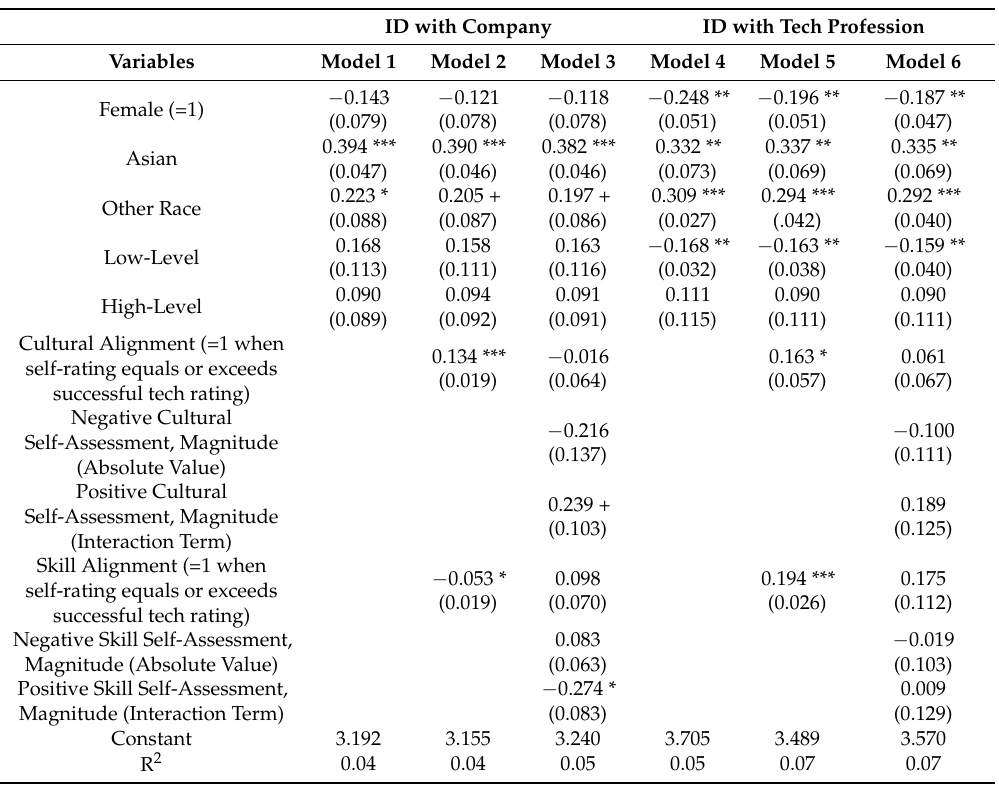
Table 2. Ordinary Least Squares Regression Estimates for the Effects of Cultural and Skill Alignment on Identity Outcomes for Silicon Valley Tech